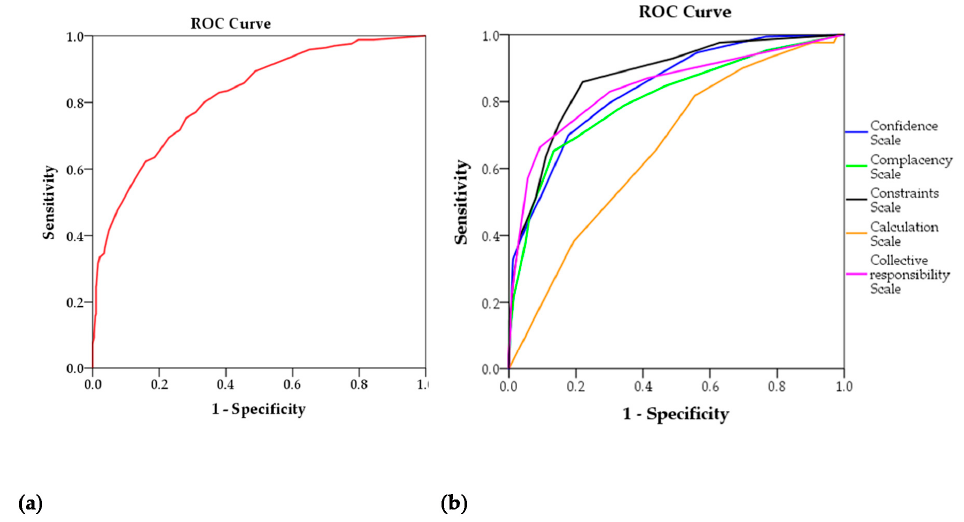
Figure 7. Receiver operating characteristic (ROC) analysis: ( a ) ROC curves of the VCBS scale in COVID-19 vaccine acceptance screening; ( b ) ROC curves for 5C subscales in COVID-19 vaccine acceptance screening.